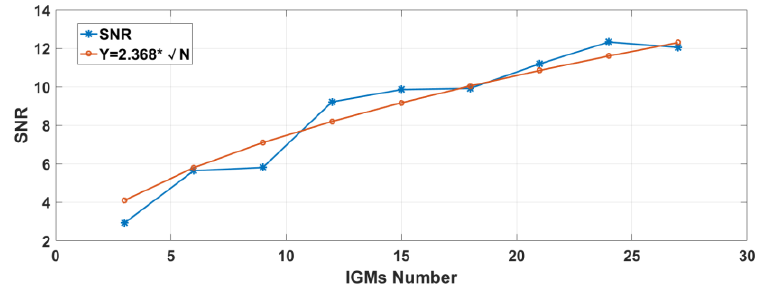
Figure 18. SNR varies with the sampling time.